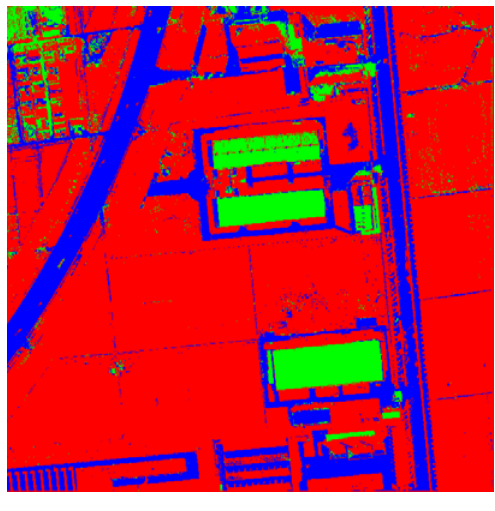
Figure 4. classificaltion result of UMSRF